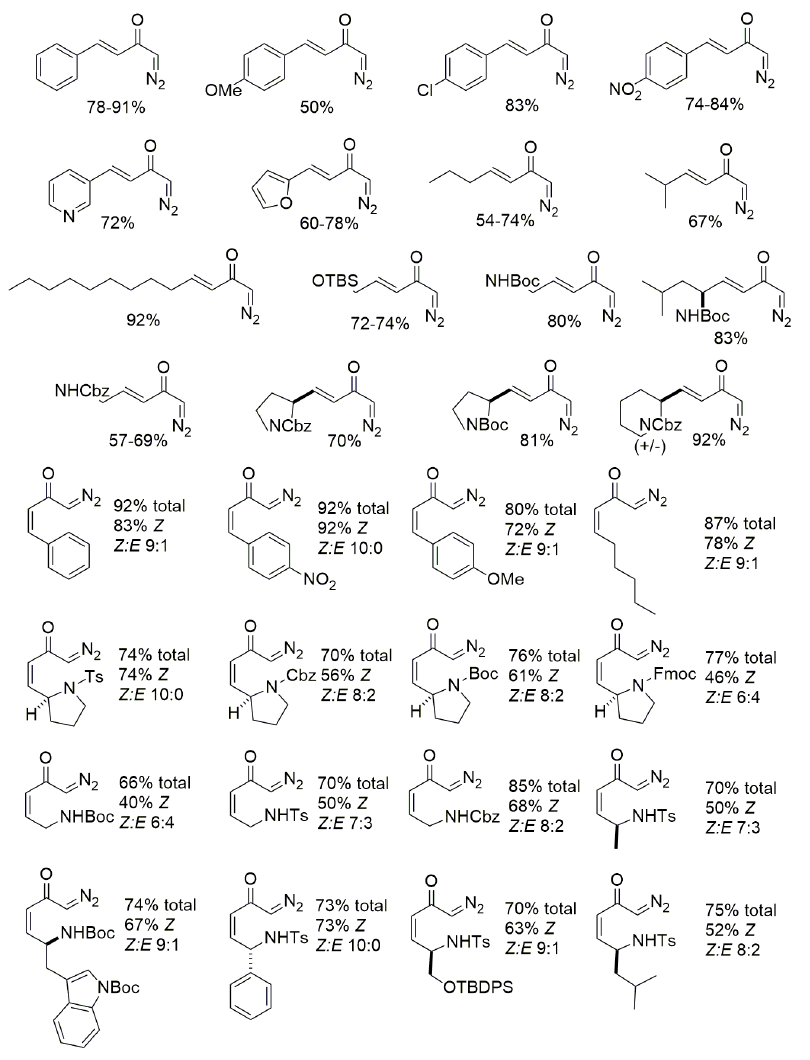
Figure 8 - Examples of Z and E α,β-unsaturated diazoketones prepared by Burtoloso’s